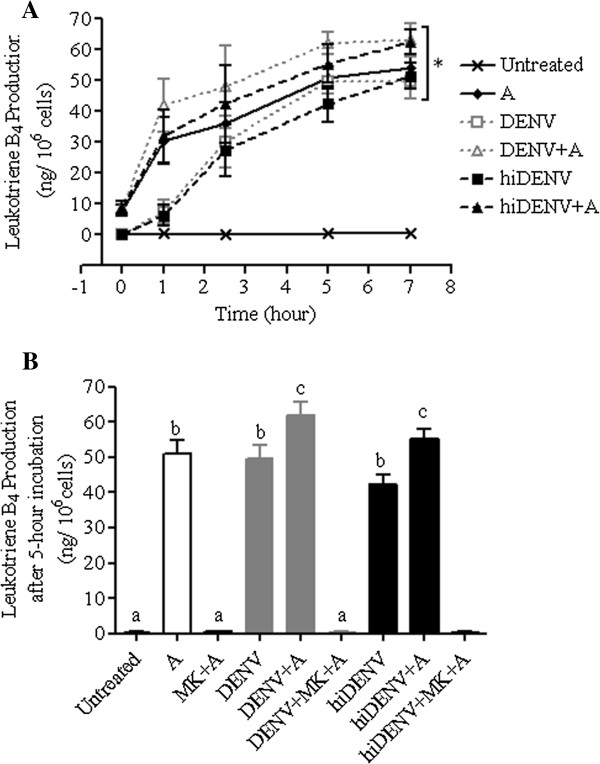
Production of leukotriene B4 by neutrophils incubated with or without DENV-2. (A) Production of leukotriene B4 (ng/106 cells) by freshly isolated peripheral neutrophils over 7-hour incubation in the presence and absence of live dengue viruses exposure (DENV-2), heat-inactivated dengue viruses exposure (hiDENV-2), and A23187 (A) treatment (N = 5). * p < 0.05 vs untreated cells using one-way ANOVA analysis of the area under the curves with Bonferroni adjustments. (B) Leukotriene B4 production (ng/106 cells) from freshly isolated peripheral neutrophils after 5 hours of incubation with or without live dengue viruses exposure (DENV-2), heat-inactivated dengue viruses exposure (hiDENV-2), MK886 (MK) and A23187 (A) treatment (N = 5). Bars with the same subscripts are not significantly different from each other using one-way ANOVA analysis with Bonferroni adjustments.